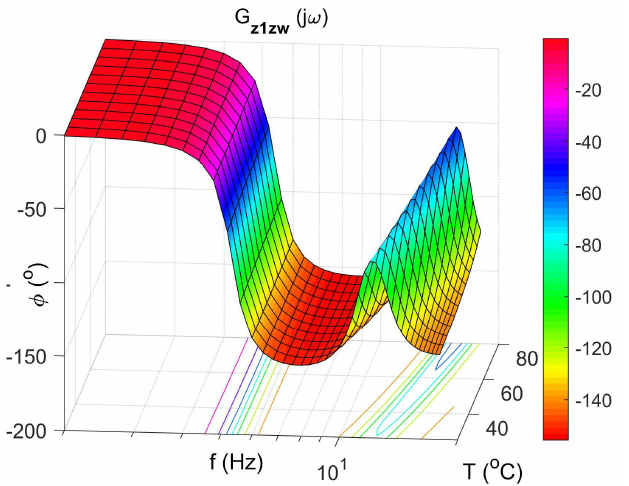
Figure 8. Vibration transmissibility function of disturbance z w to the protected mass m 1 as a function of frequency and temperature, the transfer function G z 1 zw .